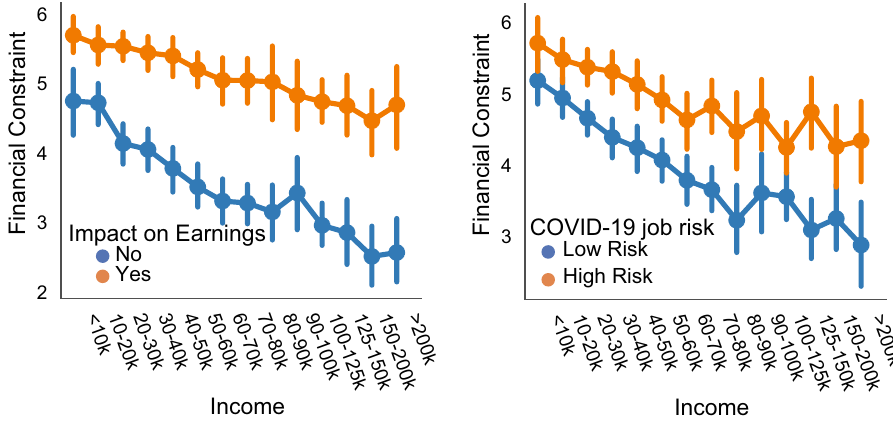
Figure 1. Relationship between financial constraint, income, and COVID-19 job impacts. Financial constraint was measured on a 7 point scale. In the left panel, the impact on earnings variable was measured on a 5 point scale, but recoded in the figure for illustrative purposes. Similarly, in the right panel, the COVID-19 job risks variable was measured on a 5 point scale, but recoded for plotting purposes. Error bars show the 95% confidence